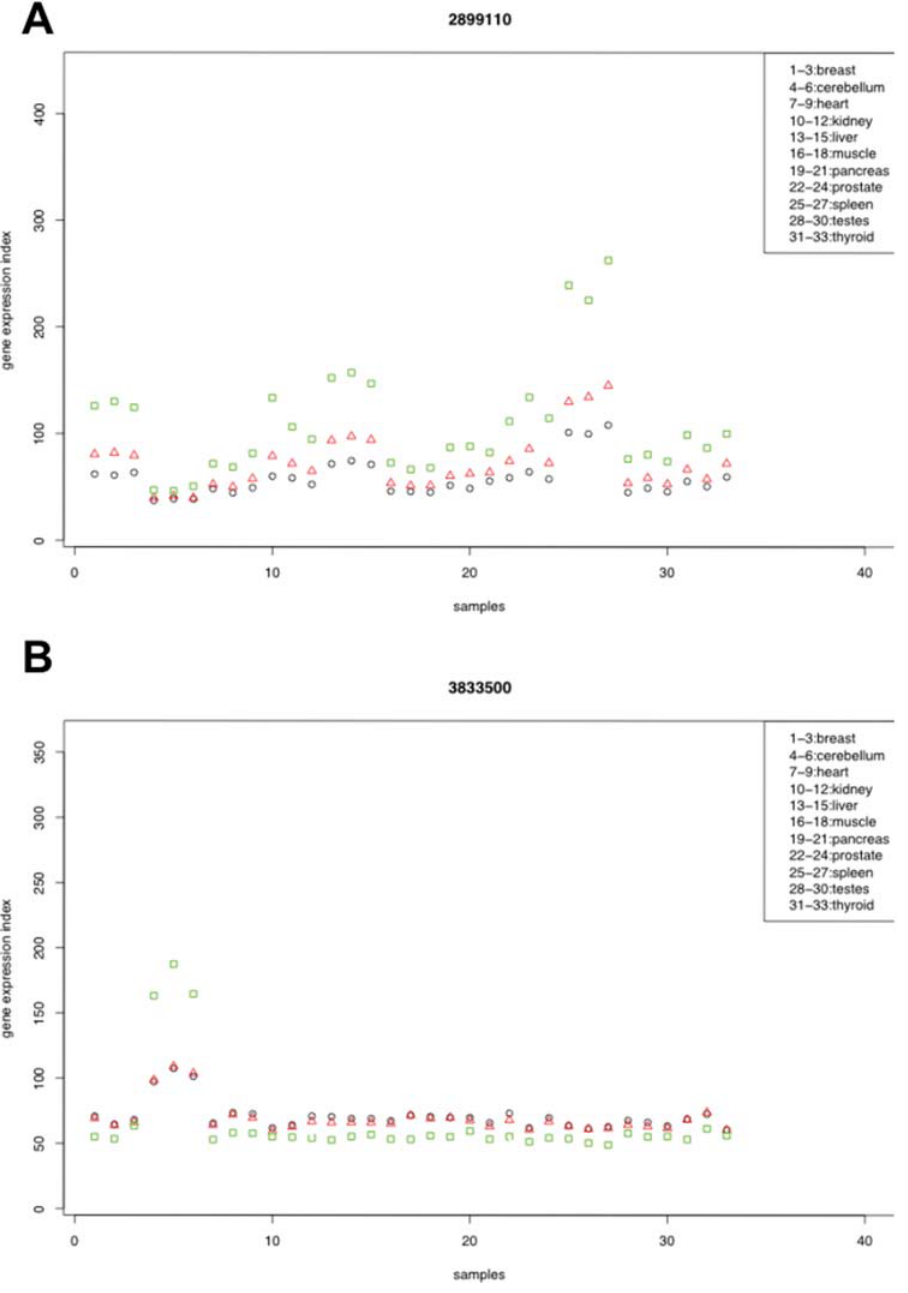
Figure 4. Gene expression indexes computed using all probes, all core probes, and selected core probes. ( A ) Gene expression indexes of transcript cluster 2899110 (HFE) are computed using all probes (black circles), all core probes (red triangles) and selected probes (green rectangles). Probe selection increases the gene expression indexes computed for all the samples. The relative expression levels in different tissues remain unaltered. ( B ) Gene expression indexes of transcript cluster 3833500 (SPTBN4, a gene known to be overexpressed in brain and cerebellum). Probe selection strengthens the pattern of overexpression in cerebellum (sample # 4, # 5 and # 6).